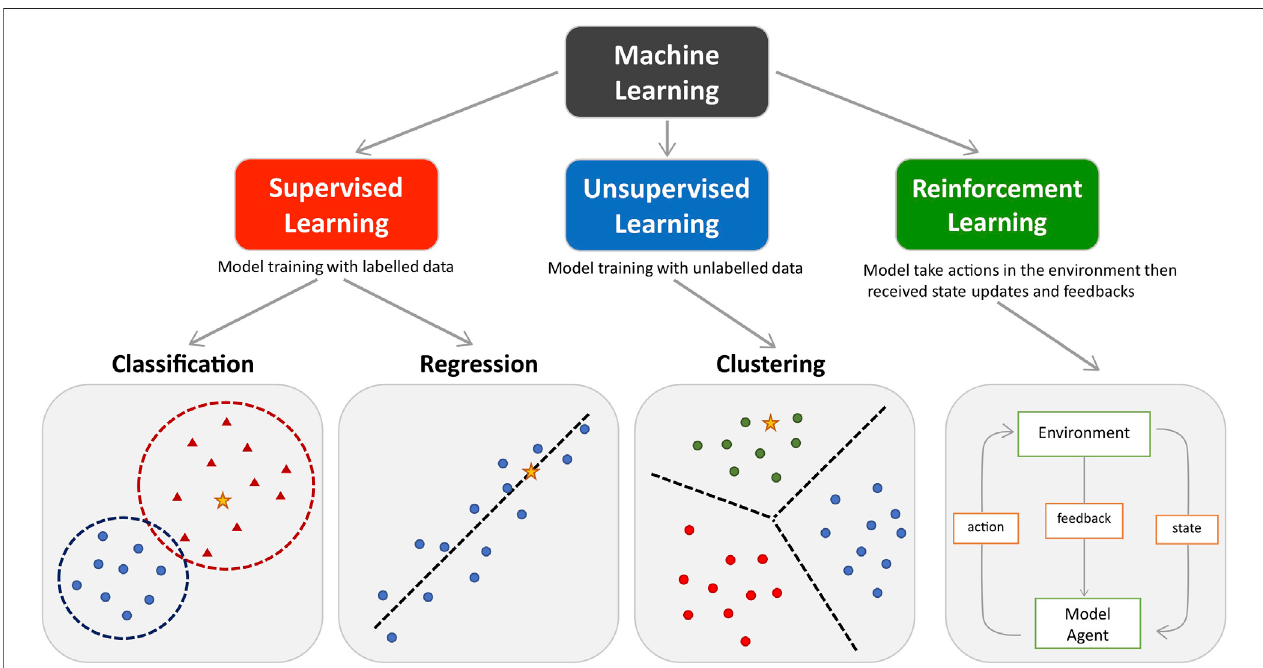
FIGURE 1 | The main types of machine learning. Main approaches include classi fi cation and regression under the supervised learning and clustering under the unsupervisedlearning.Reinforcementlearningenhancethemodelperformancebyinteractingwithenvironment.Coloureddotsandtrianglesrepresentthetrainingdata. Yellow stars represent the new data which can be predicted by the trained